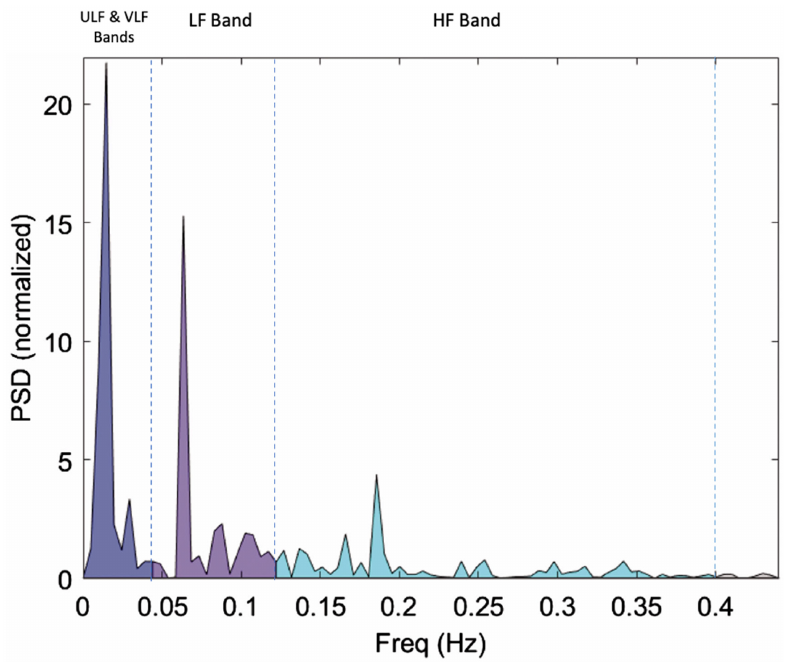
Figure 1. Power spectral density (PSD) of RR interval signal indicating ULF & VLF bands ( ≤ 0.04 Hz), LF Band (0.04–0.15 Hz), and HF Band (0.15–0.4 Hz) [Figure adapted from [42]].